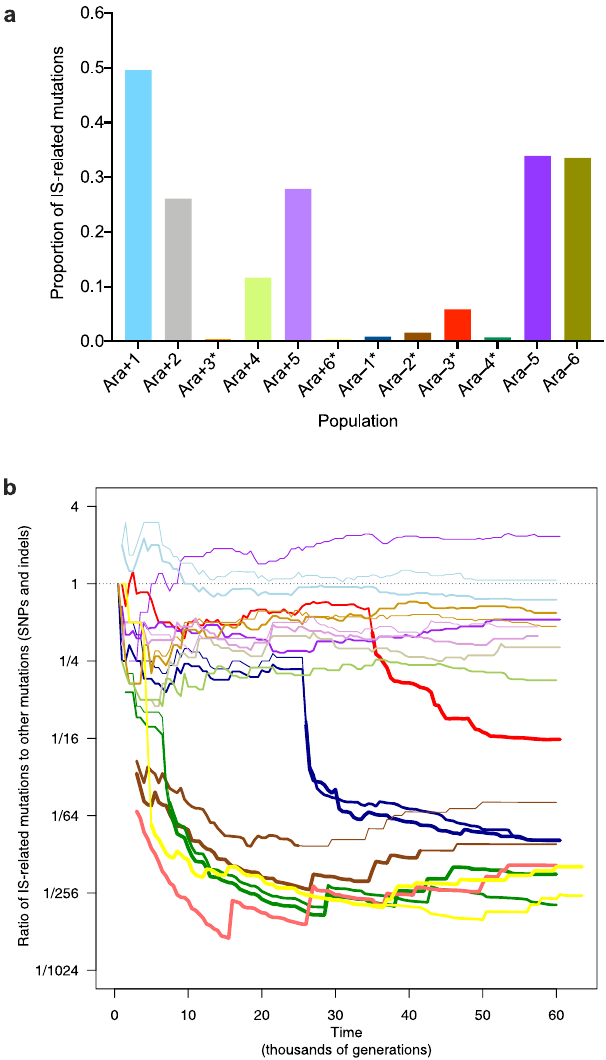
Fig. 2 Effect of mutator phenotype on IS-related mutations. a Proportion of IS-related mutations relative to total mutations after 50,000 generations. The numbers of mutations were inferred from genome sequences of evolved clones 18 . The ratios of IS-related mutations to total mutations were calculated for two clones from each population, and the data shown are the averages. Asterisks indicate six populations that evolved point-mutation hypermutability. b Ratio of IS-related mutations to other mutations (SNPs and indels) in all populations shown on a logarithmic scale. These data are based on metagenome sequences obtained from whole-population samples over time; they include only IS insertions and SNPs that eventually reached fi xation in the entire population, or in a subpopulation when a stable polymorphism was detected. The same colors are used in a and b (including Ara + 6, yellow, which is barely visible in a ). Major and minor (when present) lineages are shown by thin and very thin lines in the non-mutator populations, and by bold and lighter lines in the mutator populations. Source data are provided as a Source Data fi